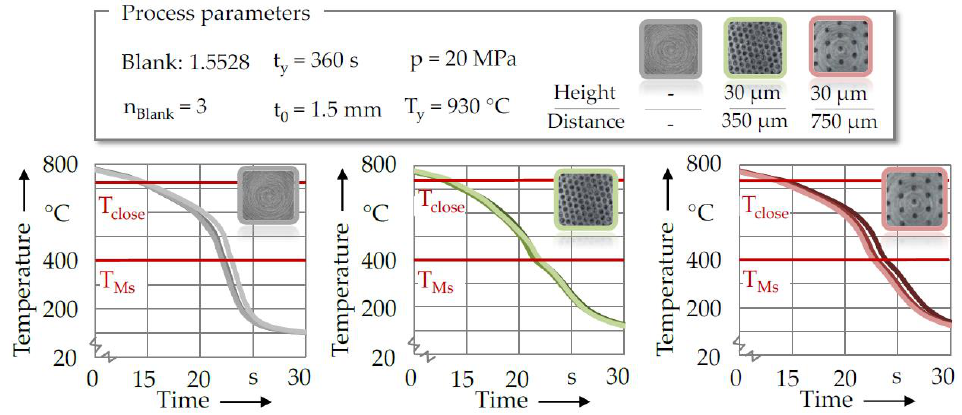
Figure 16. Recorded temperature profiles of the quenched blanks.